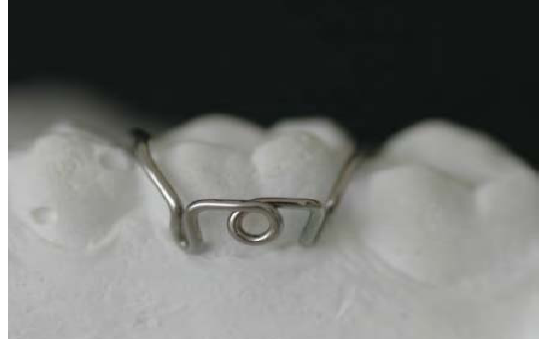
Fig.Adam’s clasp with incorporated helix